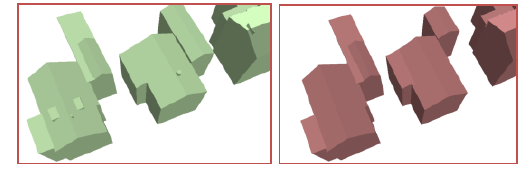
Figure 19. Snippet of final UAV (left) and ALS (Right) 3D buildings